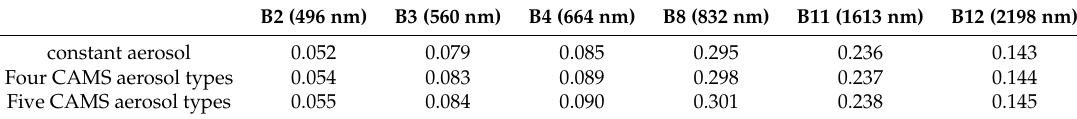
Table 13. MAJA (MACCS-ATCOR Joint Algorithm) average surface reflectances for vegetated sites. CAMS: Copernicus Atmosphere Monitoring Service.